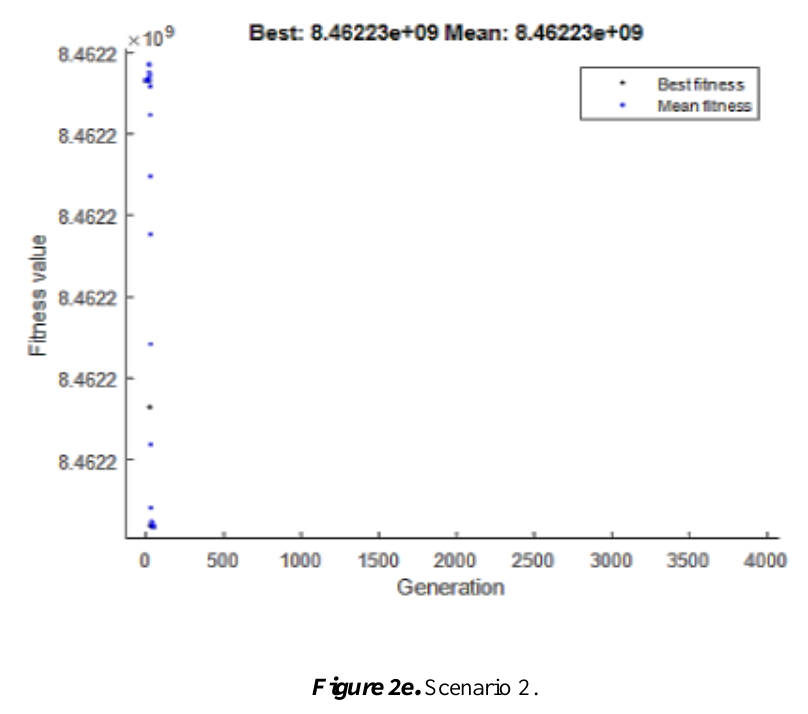
Figure 2e. Scenario 2. Figure 2. Graph for five different scenario (a), (b), (c), (d) and (e) (source: